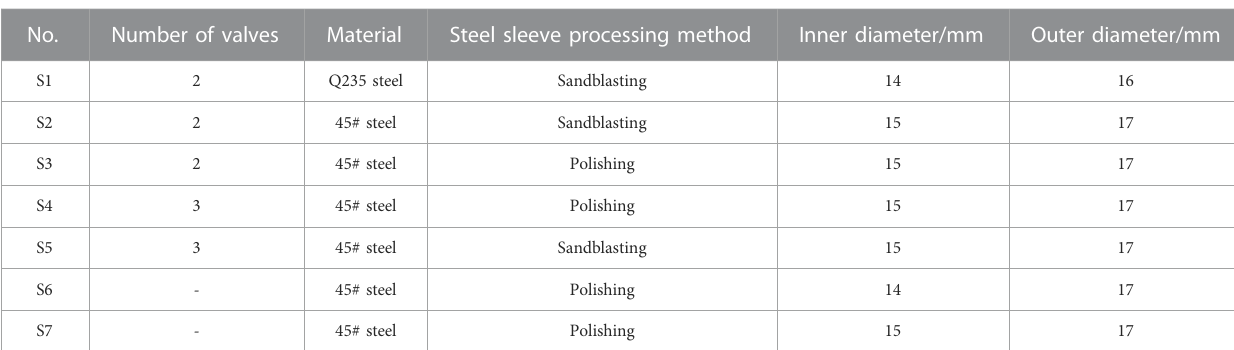
TABLE 3 Tensioning test parameters of the SBAS.